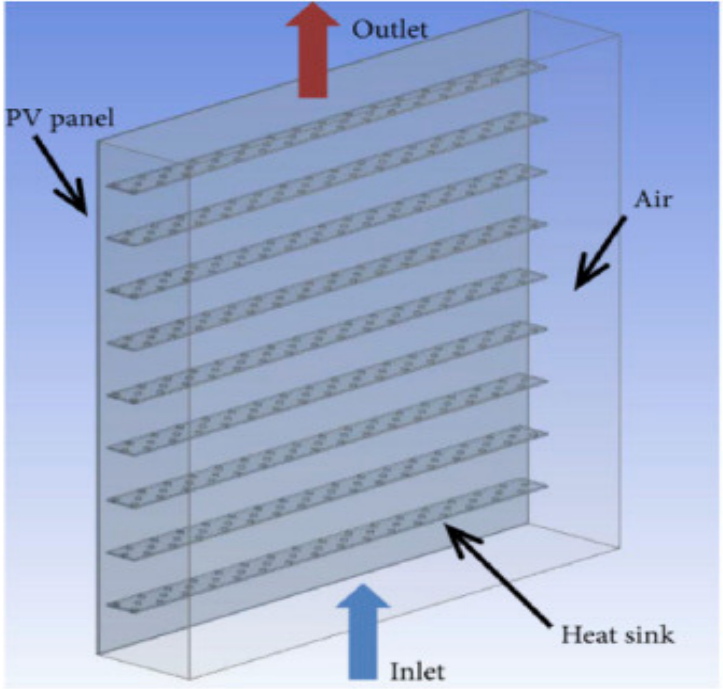
Figure 50. Model of a PV panel with a heat sink [36].